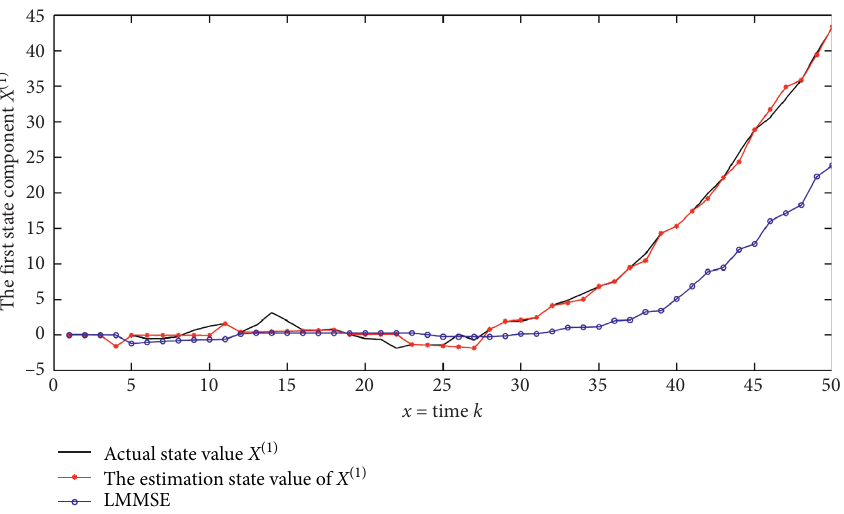
Figure 3: X ( 1 ) comparison between optimal estimation and LMMSE.